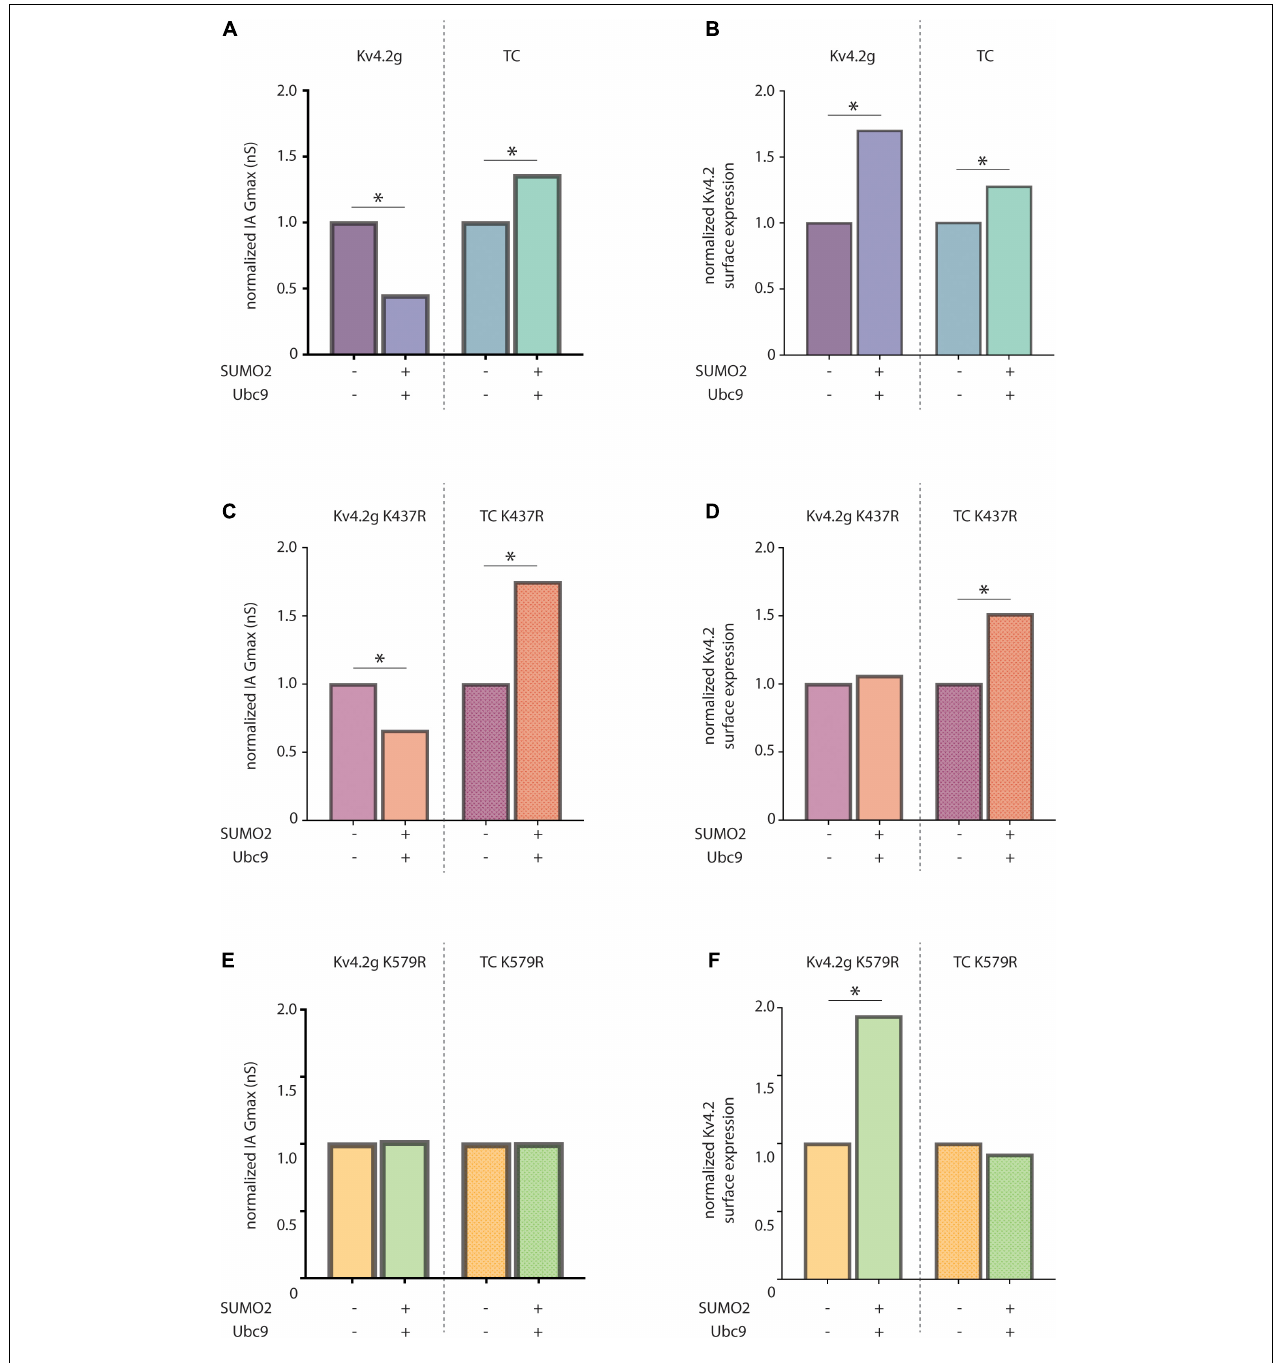
FIGURE 9 | KChIP2a and DPP10c uniquely influence the effects of Kv4.2 SUMOylation. Bar graphs show SUMOylation-induced fold-changes in mean IA Gmax (A) or mean surface expression (B) in HEK cells expressing only Kv4.2g or all 3 components of the wild-type TC. For each transfection group, e.g., either Kv4.2g or TC, means for the two treatment groups, e.g., ± SUMO2 + Ubc9, were divided by the mean for the treatment lacking SUMO + Ubc9. Bar graphs show mean normalized IA Gmax (C,E) or mean normalized surface expression (D,F) in HEK cells expressing the indicated Kv4.2g mutant or Kv4.2g mutant TC with (+) and without (–) co-expression of SUMO2 + Ubc9. Asterisk, significantly different. Data for Kv4.2g lacking KChIP2a and DPP10c were adapted from Welch et al. (2019).